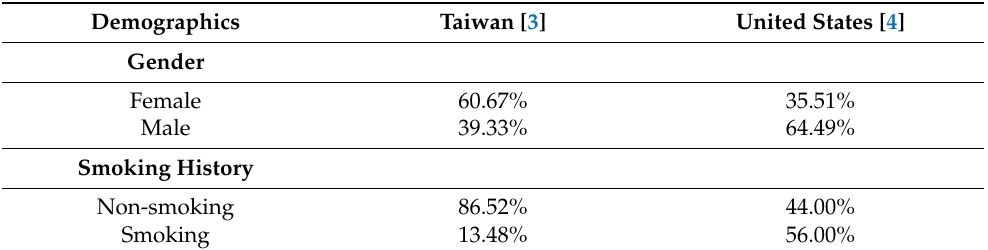
Table 1. Distinct demographics of NSCLC patients in Taiwan compared with those in United States.